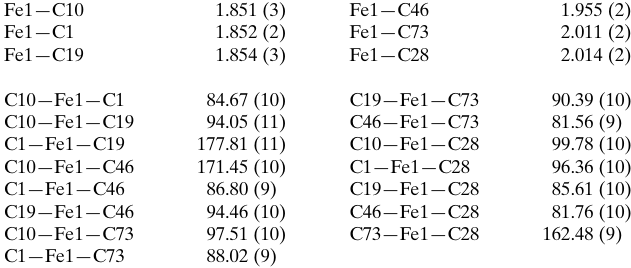
[Fig. 2, centroid–centroid distance, 3.614 (9) A˚ ]. The acceptor